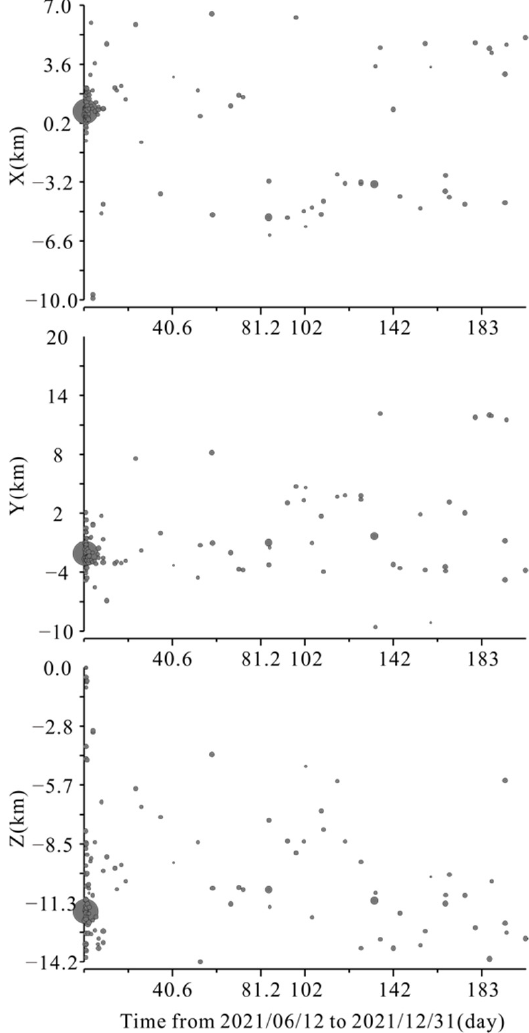
Figure 8. Time distribution of aftershock sequence in the 3D direction. X follows the longitude direction, Y follows the latitude direction, and Z follows the depth. The gray circle represents the earthquake sequence, and the large gray circle is the main earthquake.